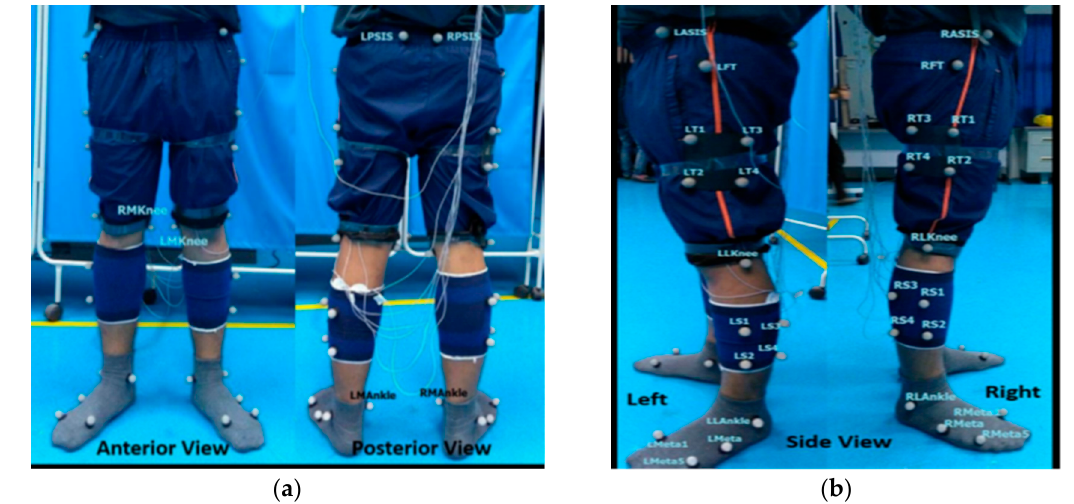
Figure 2. ( a ) Anterior and posterior views and ( b ) left and right-side views of marker placement.